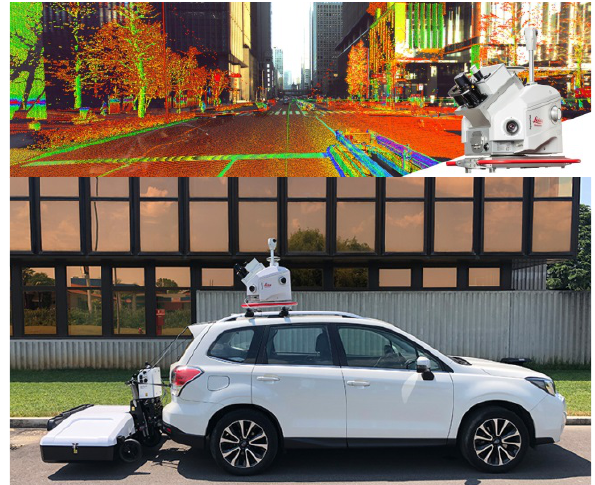
Figure 2. Leica Pegasus mobile mapping system (Leica Geosystems, 2021).